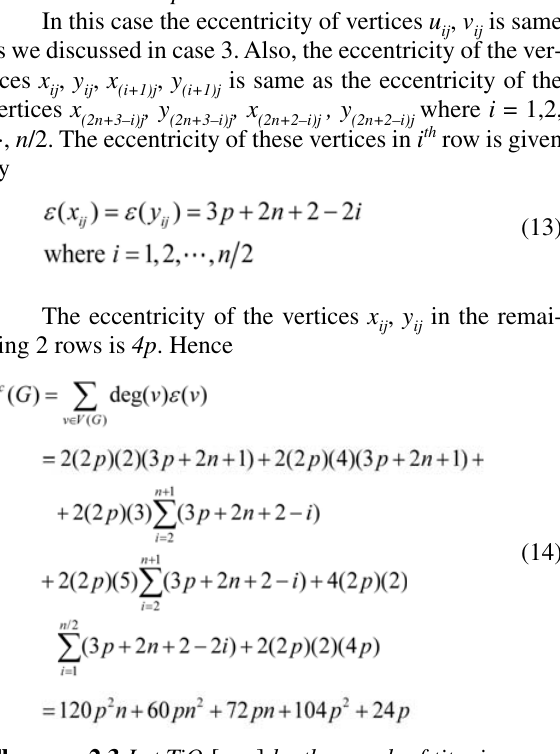
Figure 3: The shortest paths having maximal length in TiO nanotube.